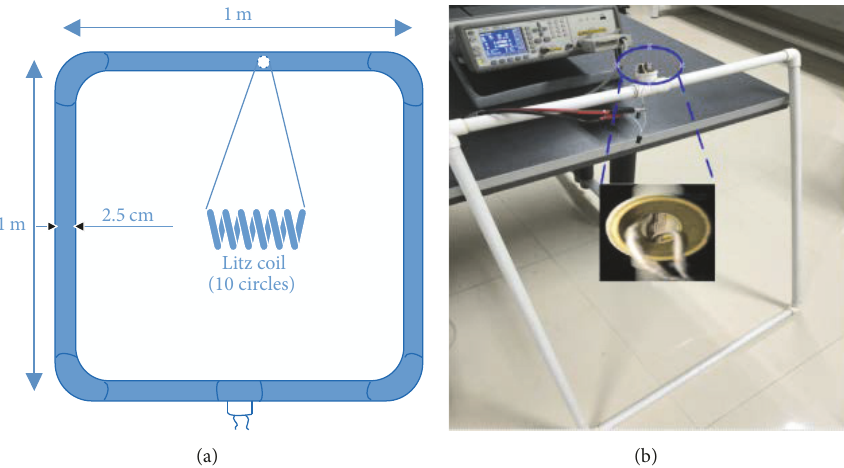
Figure 1: (a) Schematic diagram of rectangle loop antenna with shield case. (b) Photograph of rectangle loop antenna with shield case (valid at a single